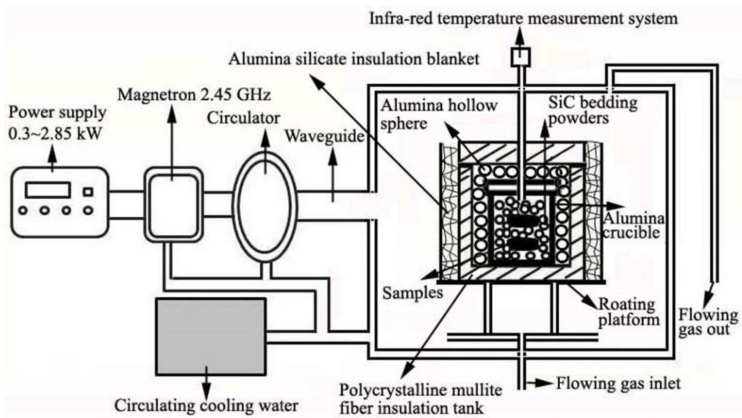
Figure 1. Schematic diagram of the microwave heating furnace.